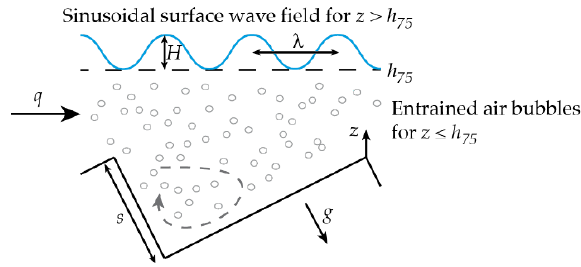
Figure 2. Schematic illustration of the considered flow structure over the step cavities consisting of a continuous air-water mixture up to h 75 and non-aerated, sinusoidal surface waves over h 75 .